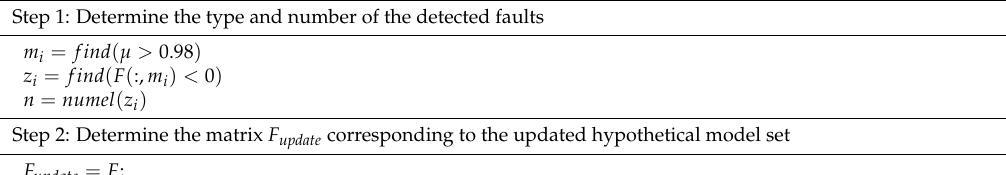
Table 1. The hypothetical mode set update